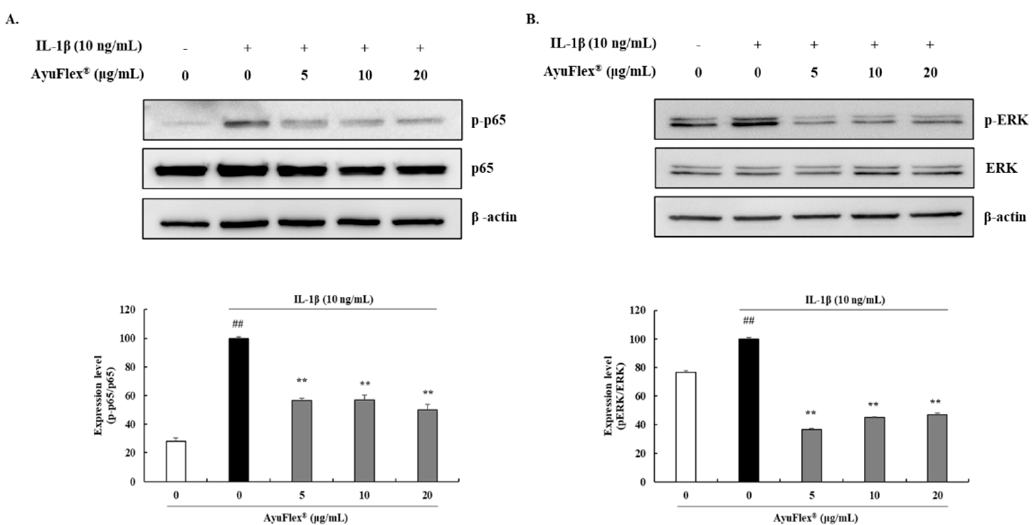
Figure 5. Effects of AyuFlex ® on the NF- κ B and MAPK mechanisms in IL-1 β -treated HCHs. HCHs were pretreated with AyuFlex ® (5, 10, and 20 µ g / mL) for 24 h and then incubated with IL-1 β (10 ng / mL) for 30 min. ( A ) The expression of NF- κ B p65 (65 kDa) and phospho-NF- κ B p65 (65 kDa) was examined with western blotting. ( B ) The expression of ERK (42, 44 kDa) and phospho-ERK (42, 44 kDa) was determined by western blotting. Western blot bands were quantified utilizing ImageJ. As the control for normalization, β -actin was utilized. ## p < 0.01, in comparison with the vehicle control group. ** p < 0.01, in comparison with the IL-1 β -treated control group.